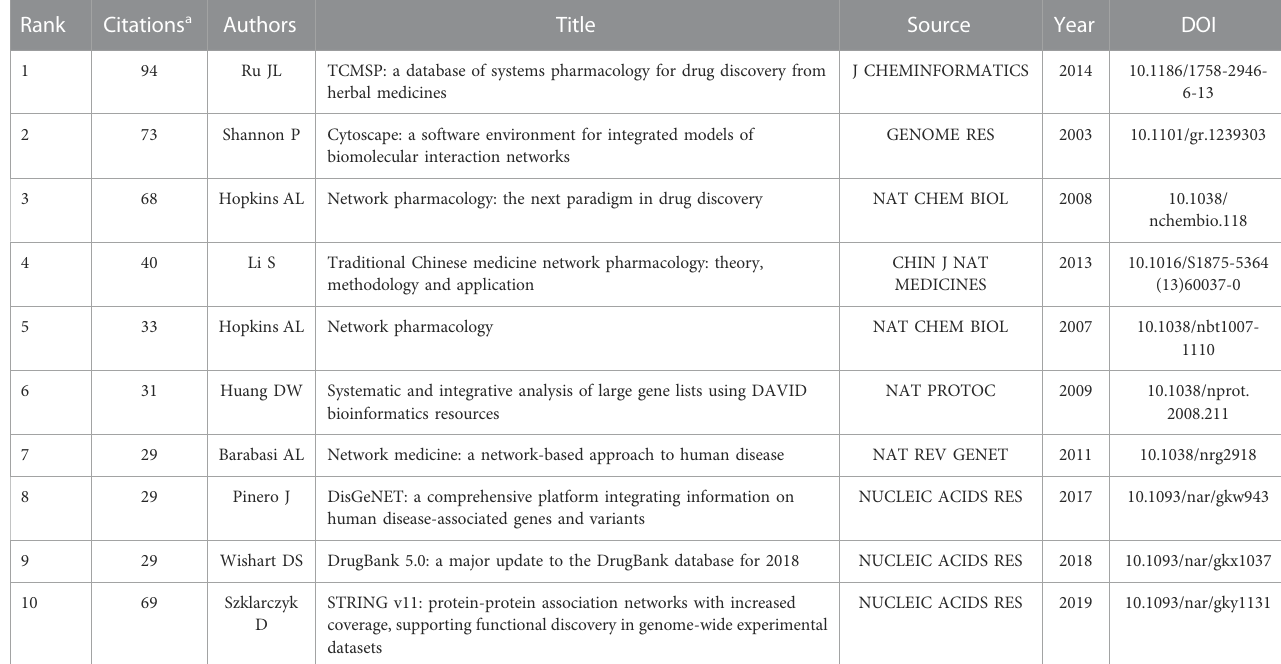
TABLE 5 Top 10 cited